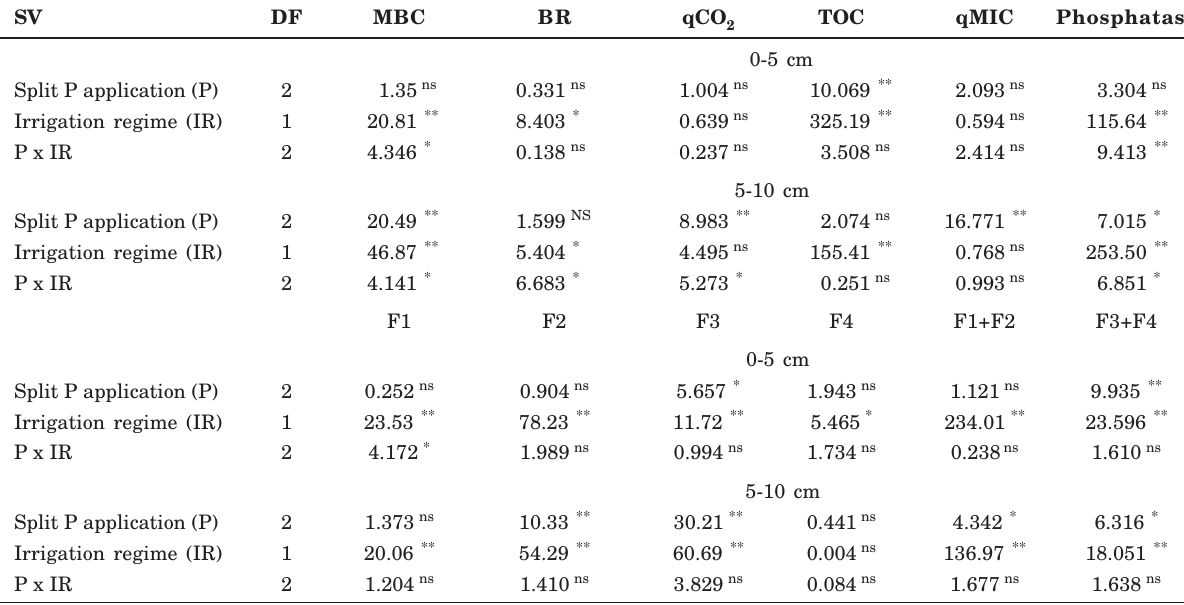
Table 1. F value and significance of the analysis of variance of the effects of the factors and their interactions on microbial biomass carbon (MBC), basal respiration (BR), metabolic quotient (qCO 2 ), total organic carbon (TOC), microbial quotient (qMic) and acid phosphatase of soil under split P applications and irrigation regimes and their interactions, in the layers 0-5 and 5-10 cm SV DF